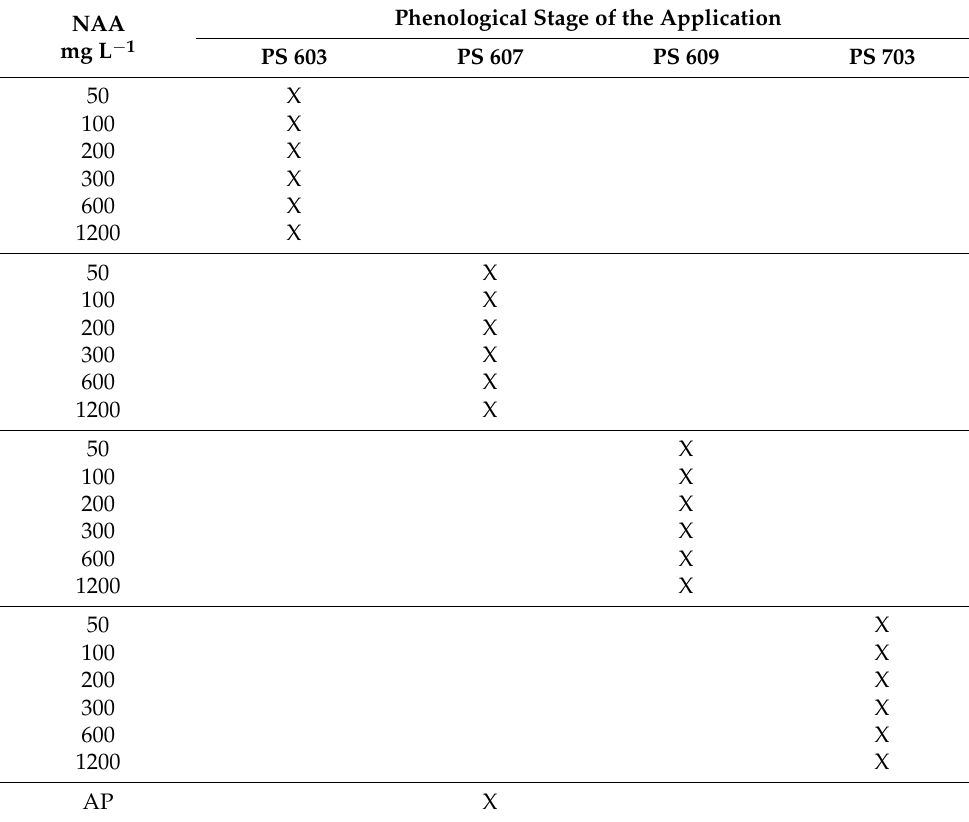
Table 1. Treatments for the definition of phenological stage and naphthalene acetic acid (NAA) concentration for triggering parthenocarpic fruit formation in OxG hybrids (Coari x La M é ). NAA solutions were applied once at different phenological stages. Assisted pollination treatment was performed only in inflorescences in anthesis (phenological stage 607). Phenological Stage of the Application NAA mg L − 1 PS